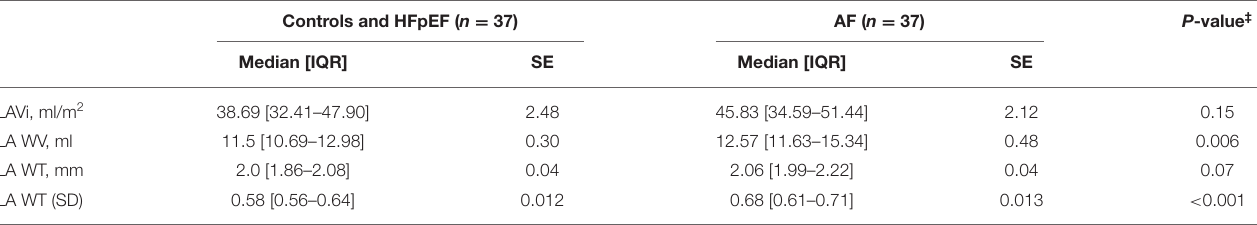
TABLE 3 | Comparisons of atrial structure and LA wall indices of the study subjects by MDCT after matching. Controls and HFpEF ( n = 37) AF ( n =